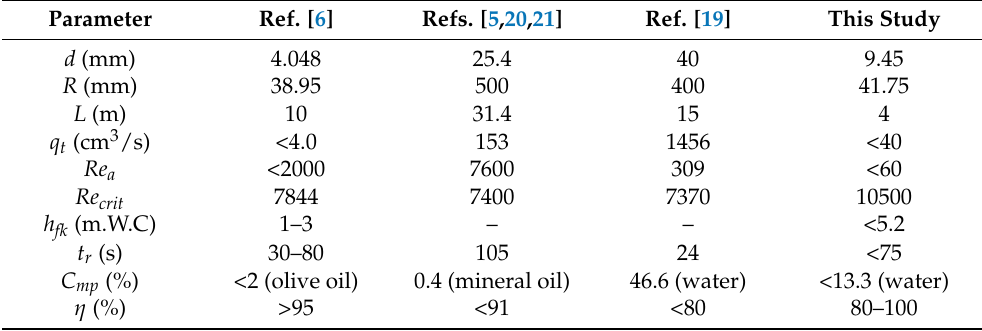
Table 1. Characteristic values of the separation tests conducted in some works directly related to this study ( C mp refers to the concentration of the minority phase in each